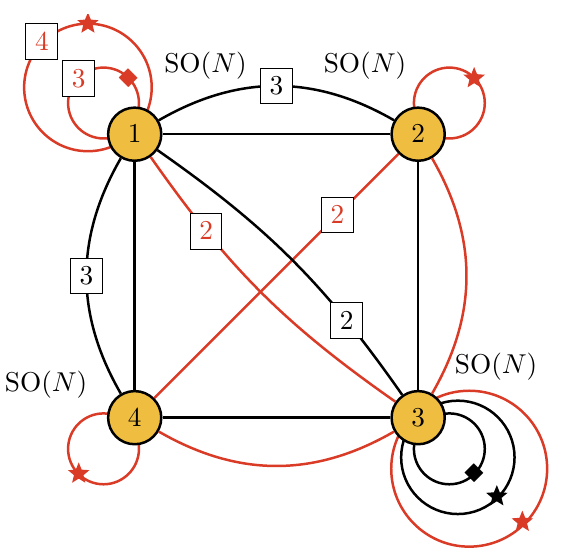
Figure 9 . Quiver diagram for the Spin(7) orientifold of phase A of H 4 using the universal involution.